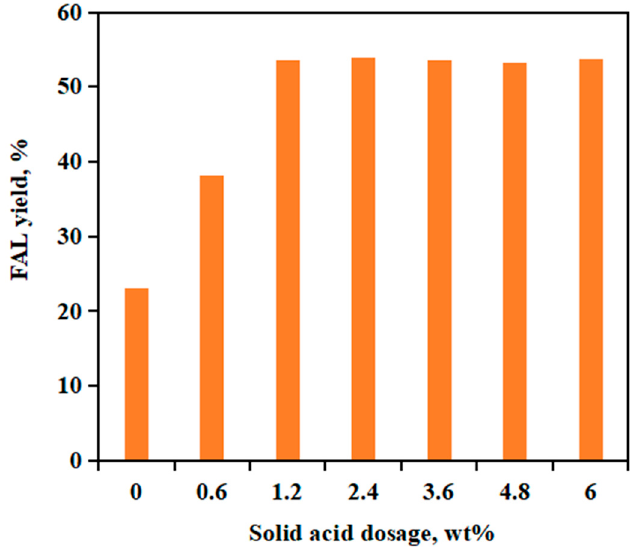
Figure 6. Effects of solid acid dosage (0–6 wt%) on the FAL formation in ChCl:PEG10000–water (20:80, wt/wt) (CS 75 g/L, 170 °C, 30 min). (20:80, wt/wt) (CS 75 g/L, 170 ◦ C, 30